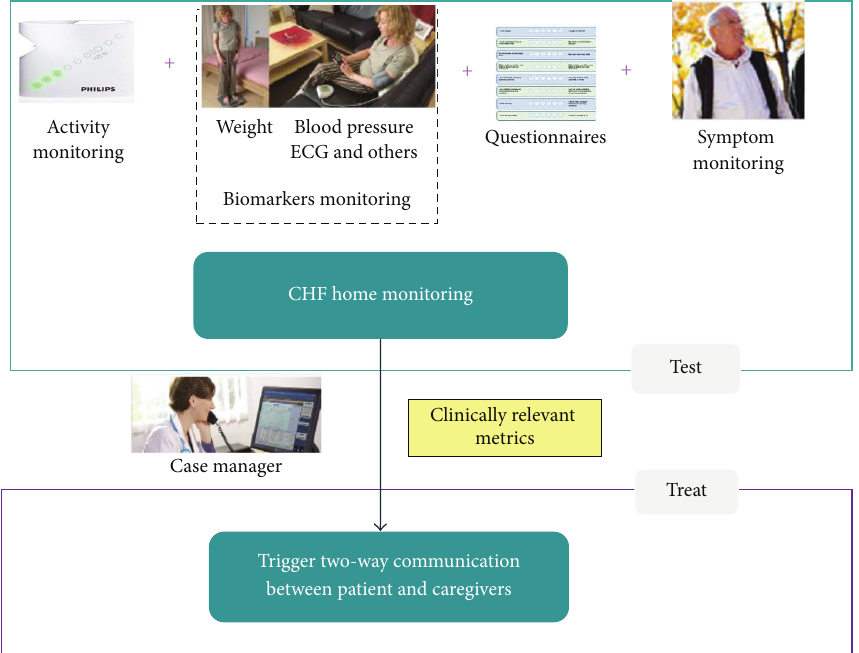
Figure 1: Schematic of a home-based telehealth program for monitoring CHF patients. Note that TEST includes one or more of the monitoring measures: activity monitoring, biomarker monitoring, questionnaires, and symptom monitoring; TREAT includes one or more of the following: case manager reviewing data, telephone triage, physicians’ initiation of medication package, and nurse home visit (if